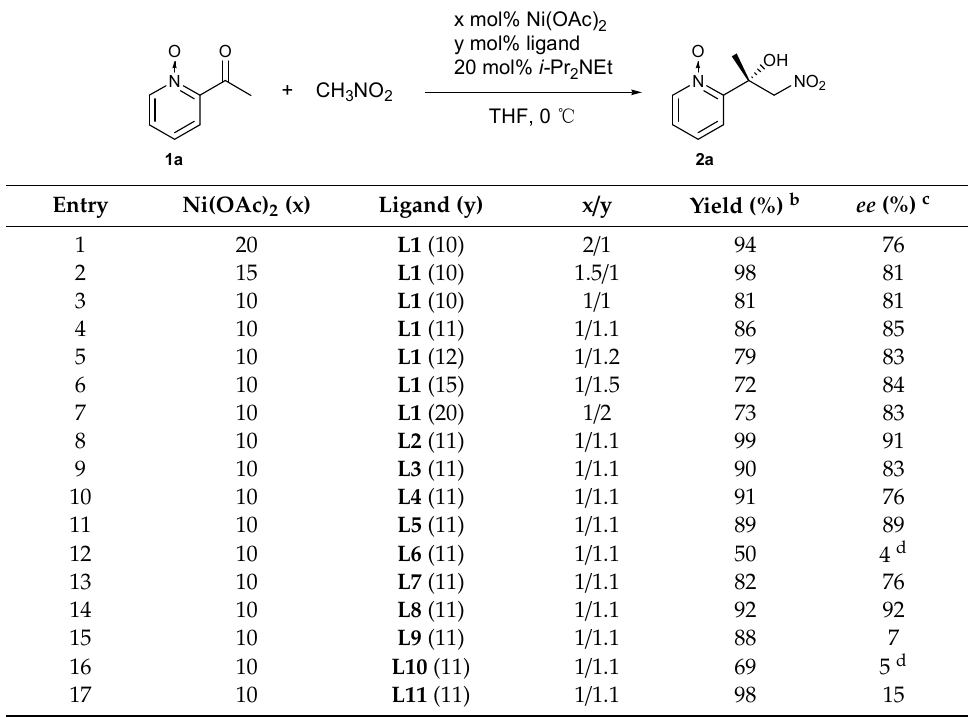
Figure 1. Structures of ligands. Table 1. Effect of the metal/ligand ratio and the ligand structure in the asymmetric Henry reaction a .